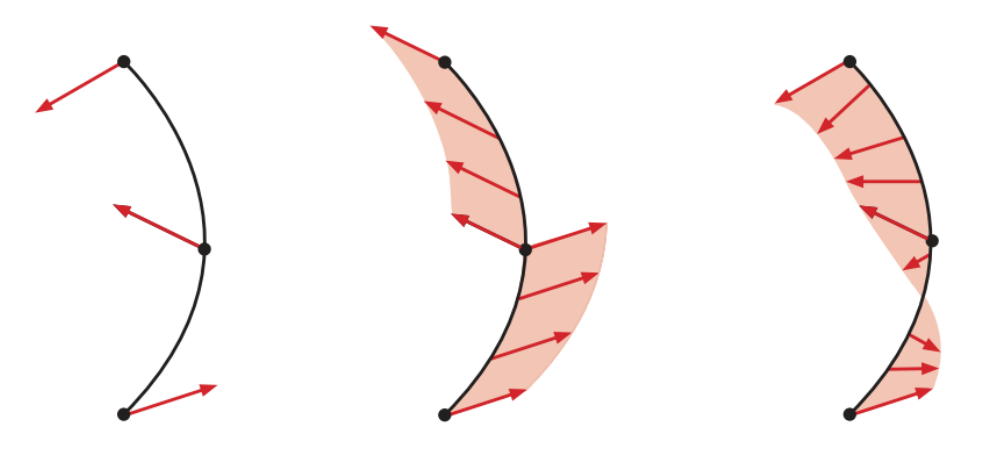
Figure 4. From left to right: The Kepler model, the Stark model, and the Continuous model. Additionally, analytical solutions can be derived under constant radial or tangential thrust without space perturbations, even including some environmental effects, such as the Earth